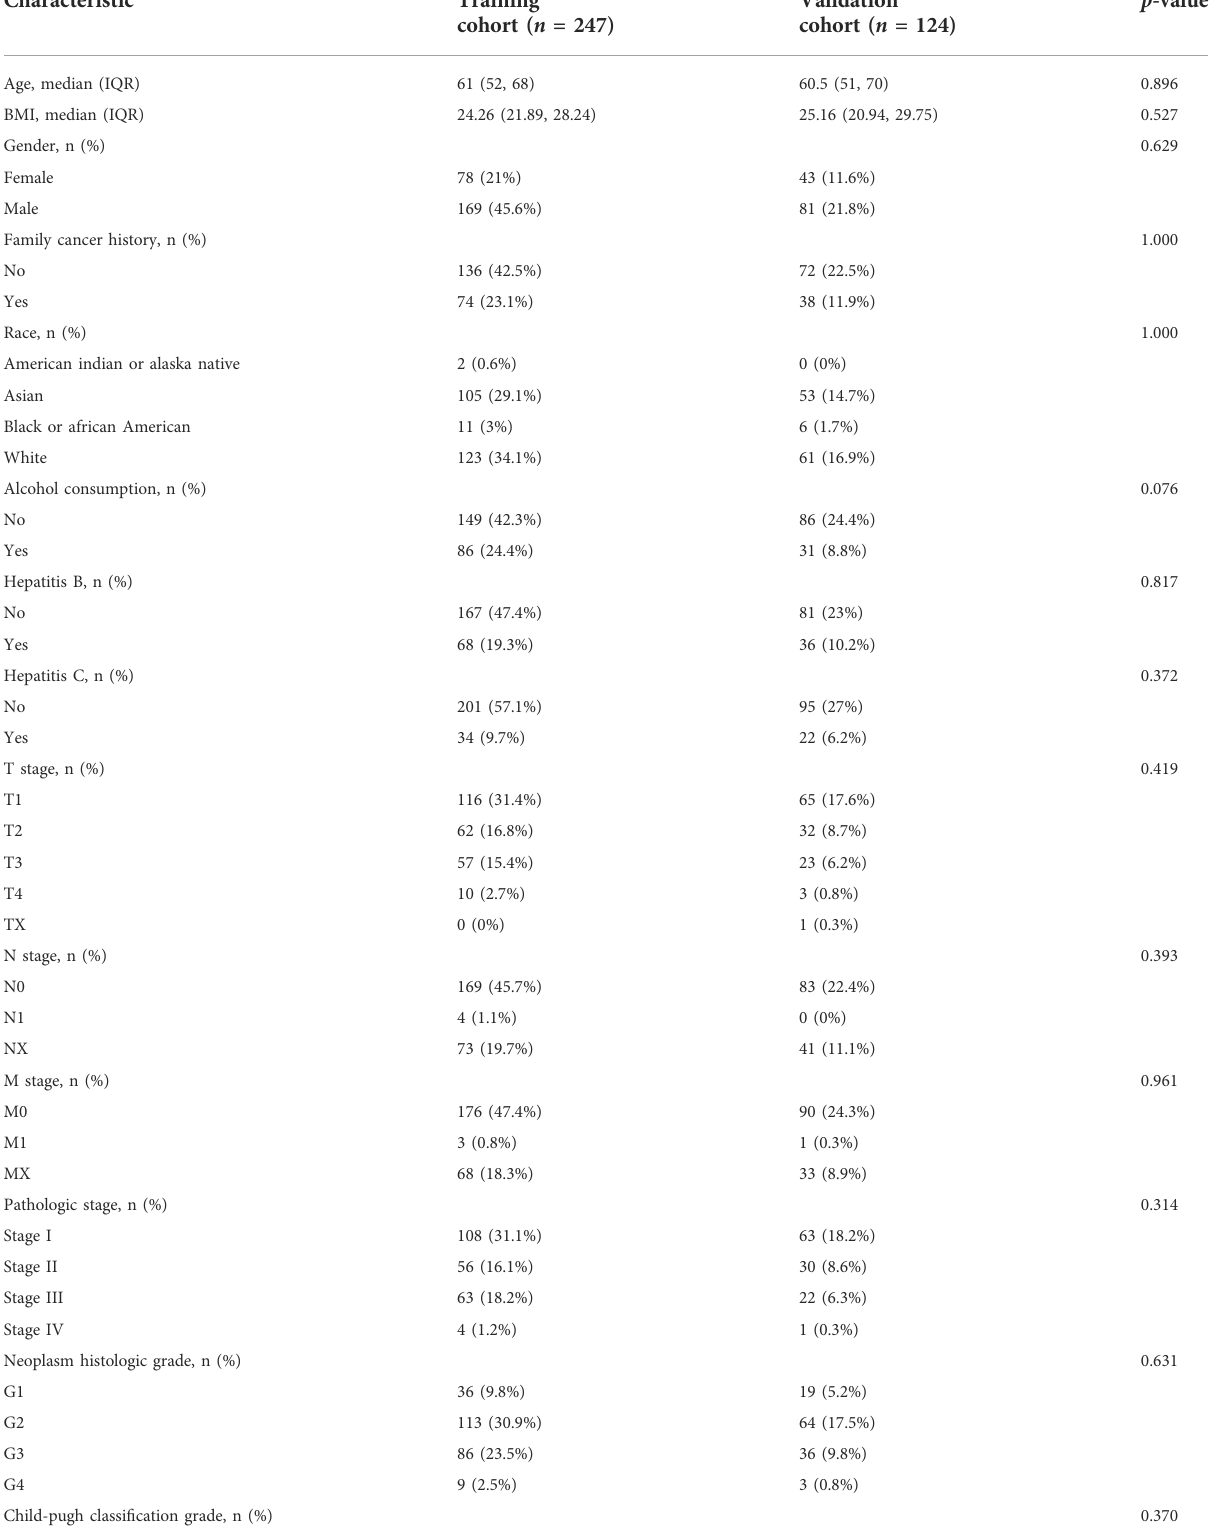
TABLE 1 The characteristics of liver cancer patients in the training cohort and validation